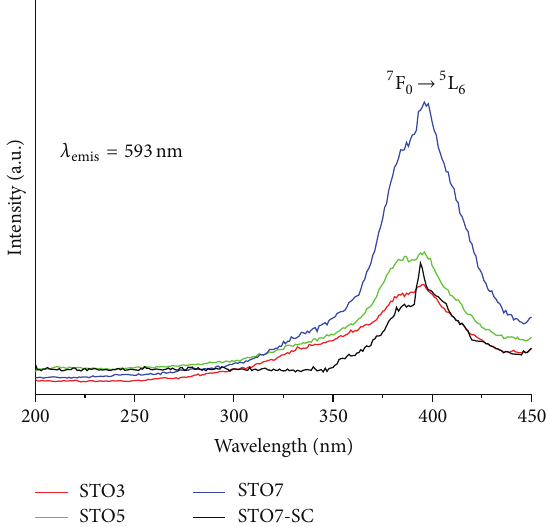
Figure 4: Excitation spectra of samples STO3, STO5, STO7, and STO7-SC.